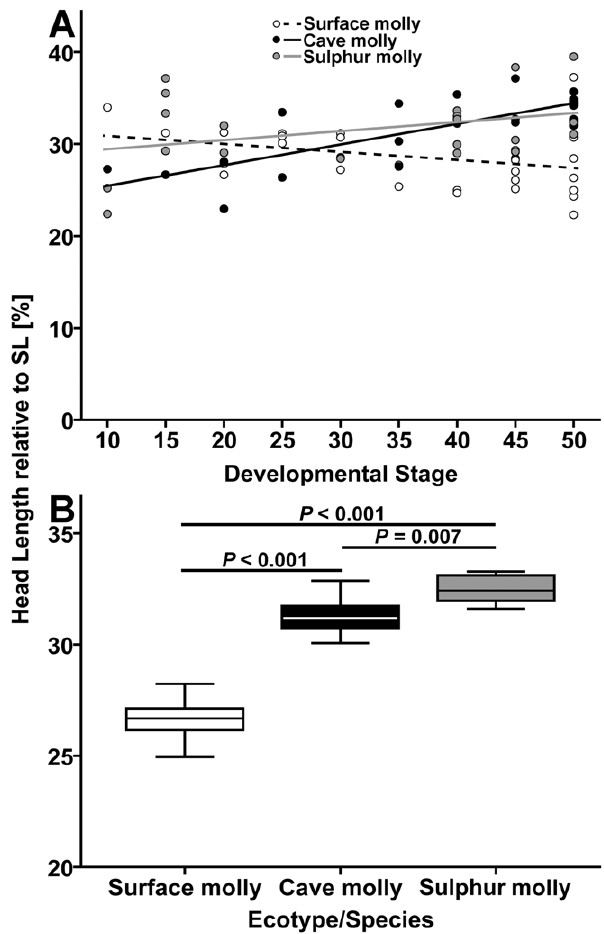
Figure 7. Relative eye size in three types of mollies. ( A ) Scatter plots of eye diameter to SL ratio vs. stage of development in molly embryos from one benign and two extreme habitats. Stages 0, 2 and 5 are not depicted, because they lack a differentiated head. ( B ) Box plots (median and IQR) for the ‘eye diameter to SL’ ratio in adult fish ( N =10 per population). P -values refer to Fisher’s LSD post hoc tests. Test statistics for both graphs are presented in the results section.